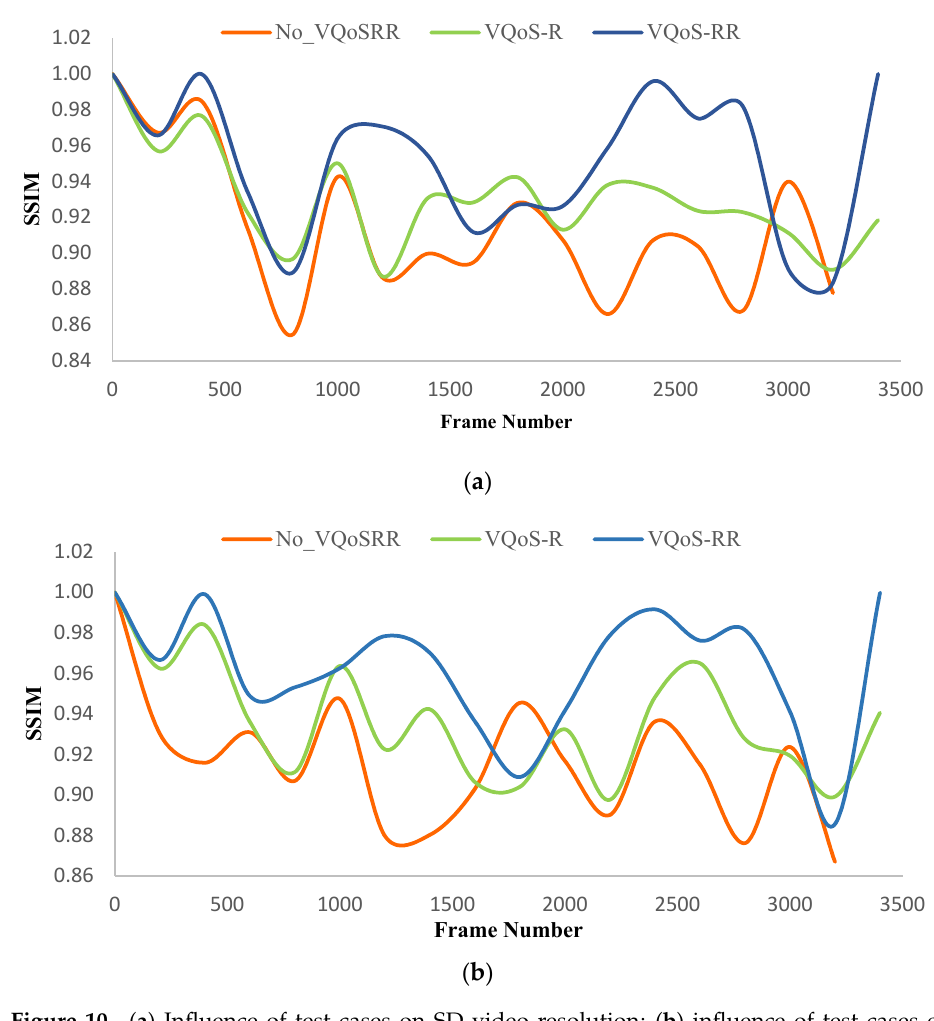
Figure 10. ( a ) Influence of test cases on SD video resolution; ( b ) influence of test cases on the HD video.